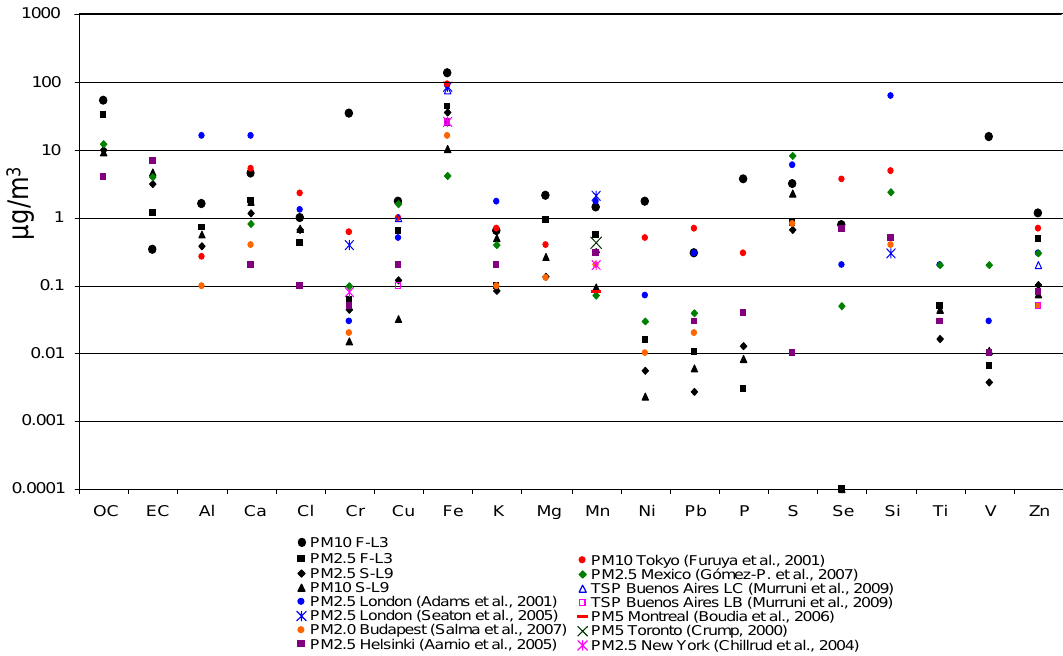
Figure 9 Fig. 9. Comparison of mean levels of selected components in PM 10 and PM 2 . 5 obtained at Fontana (L3) and Sagrera (L9) platforms with those reported from other studies carried out in different metro systems worldwide.